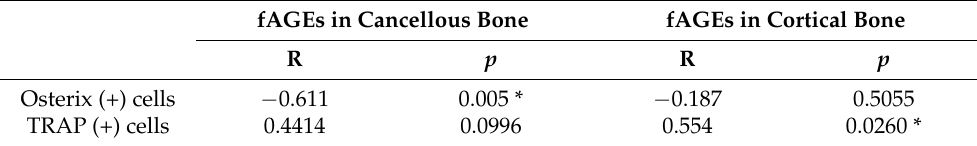
Table 3. Pearson correlation coefficient between fAGEs and bone metabolism (* p <